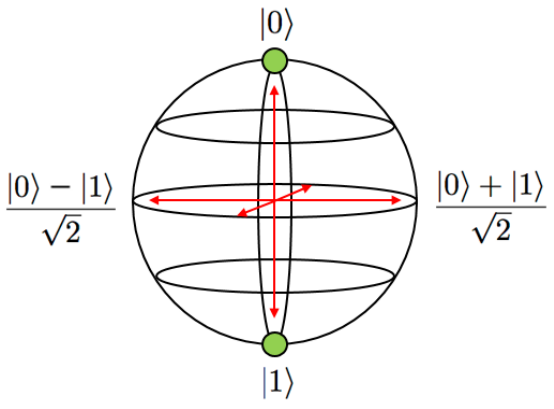
Figure 2. AES-128 encryption/decryption